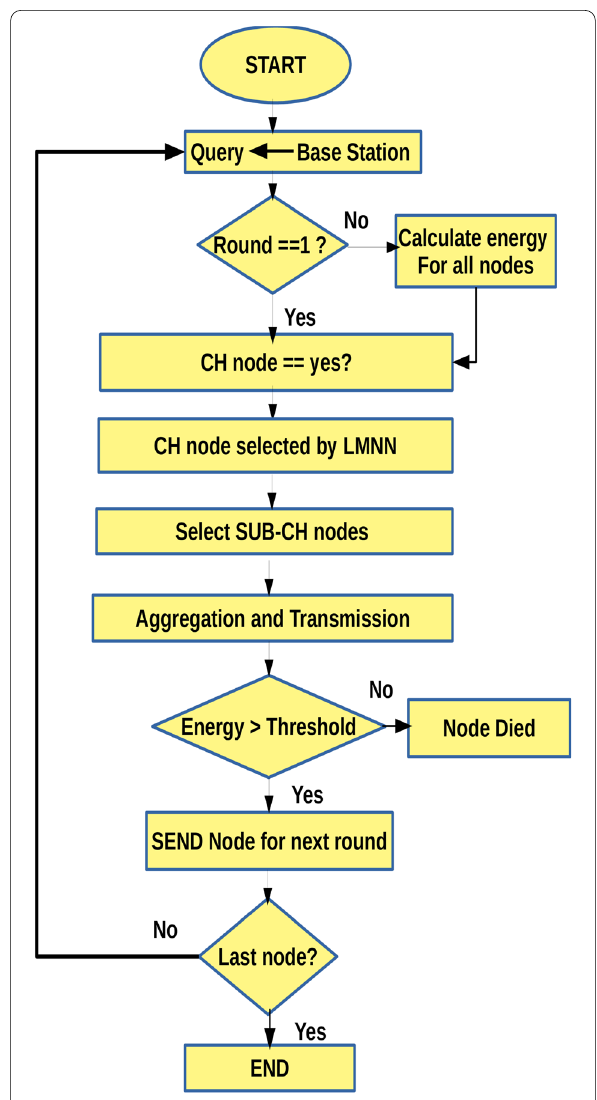
Fig. 3 Step by step representation of Sub-cluster LEACH-LMNN